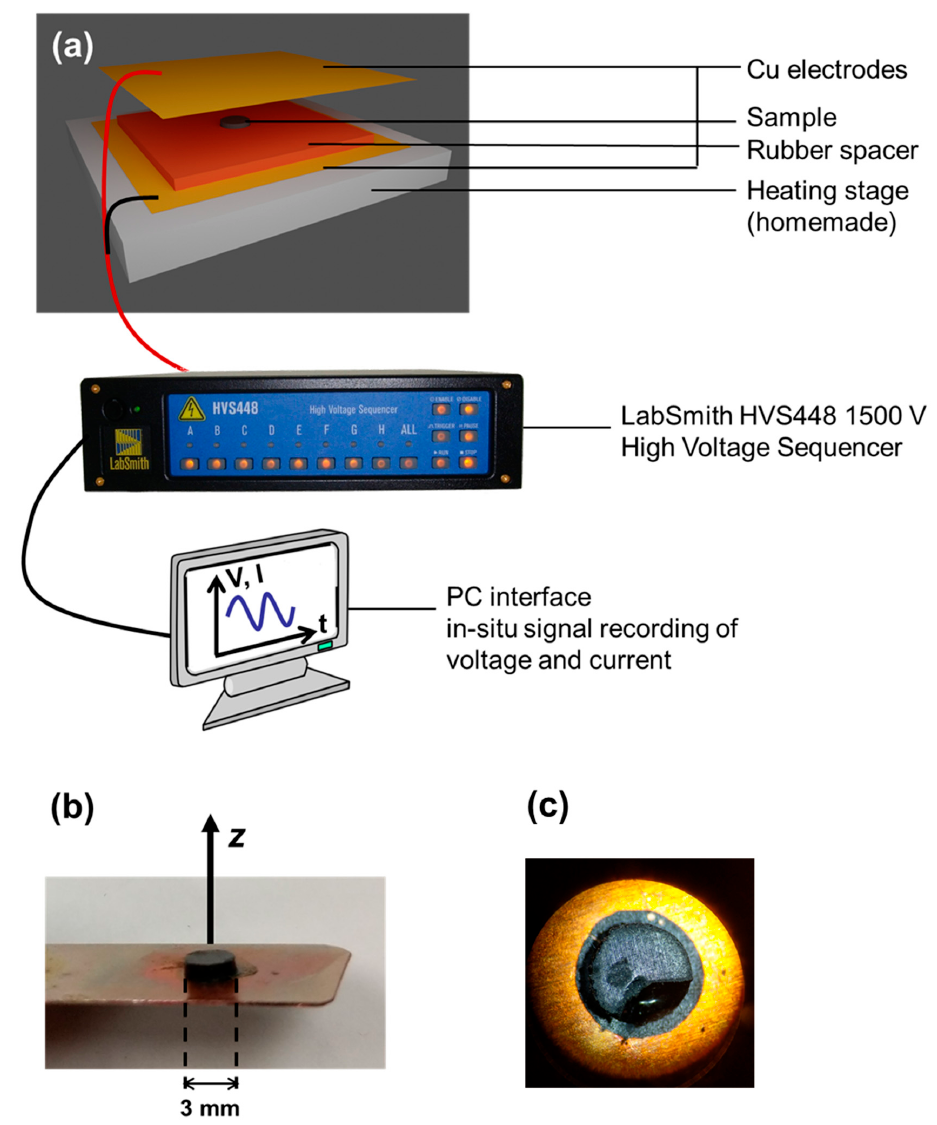
Figure 1. ( a ) Experimental setup for electric field application to polymer melt. ( b ) Test specimen of EVA/GNP_0.25 wt% mounted on a Cu electrode prior to electric field application. Sample dimension and electric field direction ( z ) denoted. ( c ) Test specimen after electric field application. Polymer degradation occurred in part of the sample (lower right portion of the image showing a